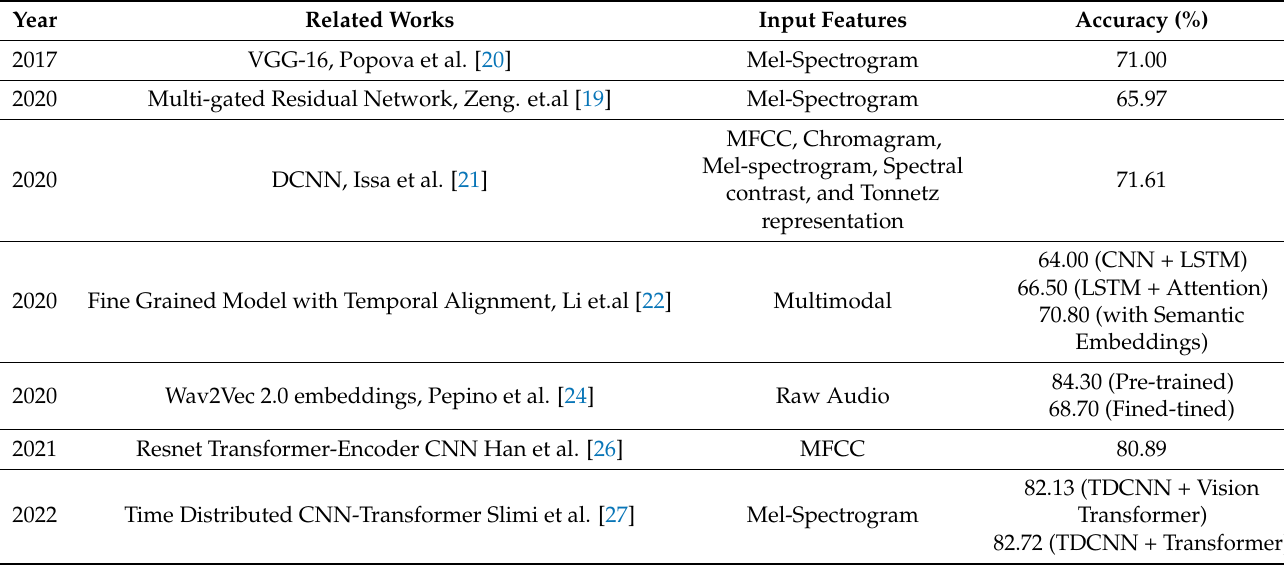
Table 2. Comparison of reviewed literatures of SER system trained on RAVDESS